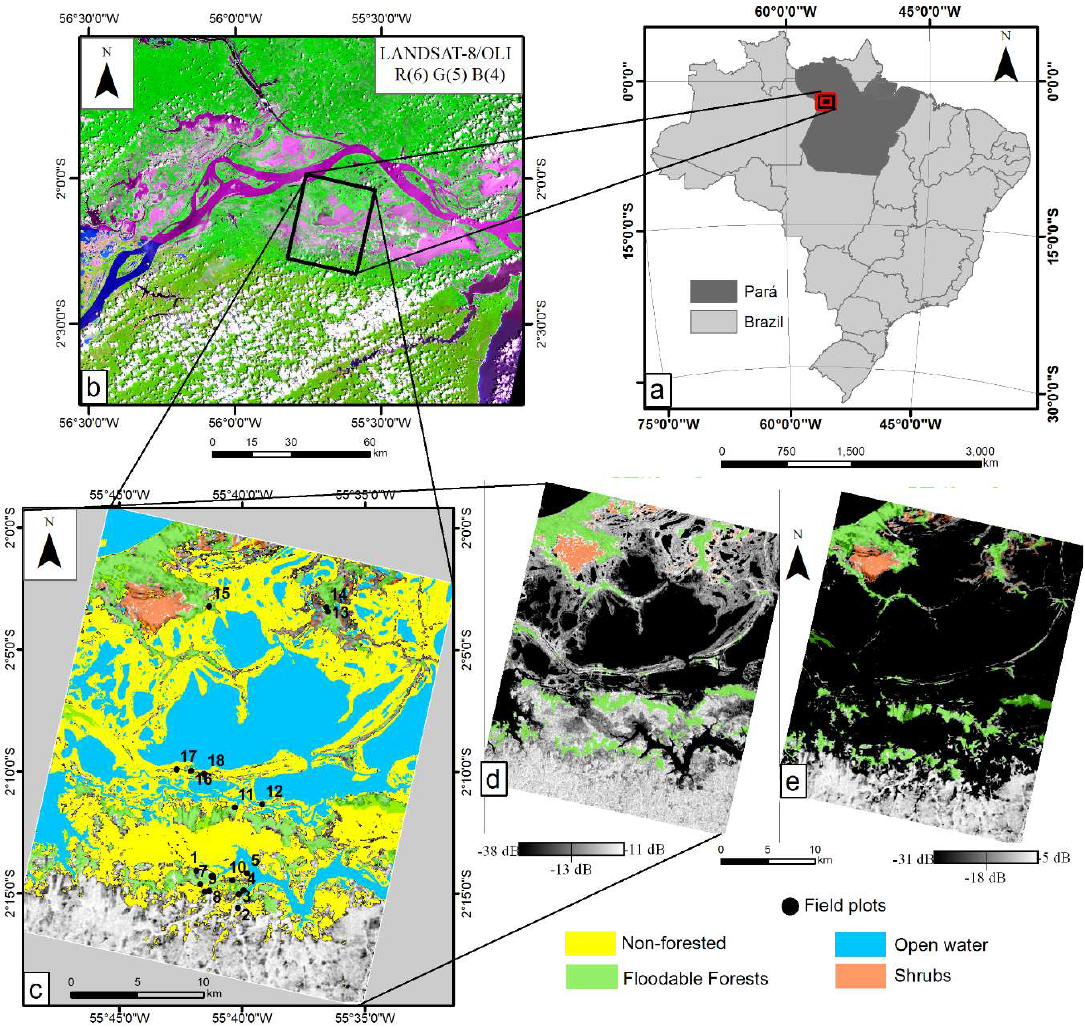
Figure 1. ( a ) Location of Pará state (dark gray) within Brazil (light gray); ( b ) detailed view of the Lago Grande de Curuai; ( c ) classes and field plots location; ( d ) Radarsat-2 HV image in low-water season; ( e ) advanced land observing satellite (ALOS)/ phased-arrayed L-band Synthetic Aperture Radar (PALSAR-1) HV image in high-water season.